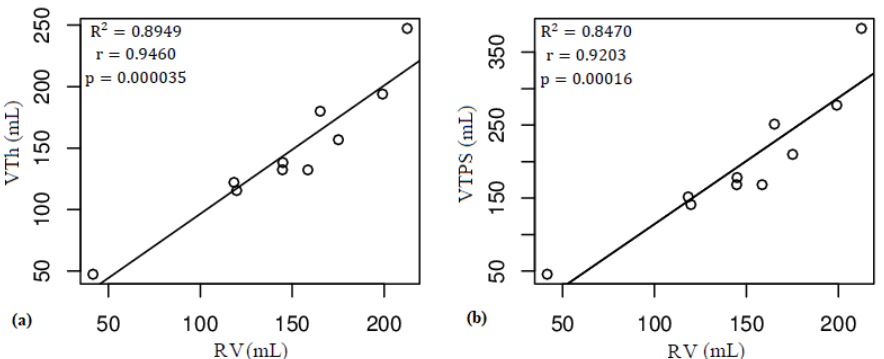
Figure 5. Linear correlations obtained: between RV and VTh ( a ); and between RV and VTPS ( b